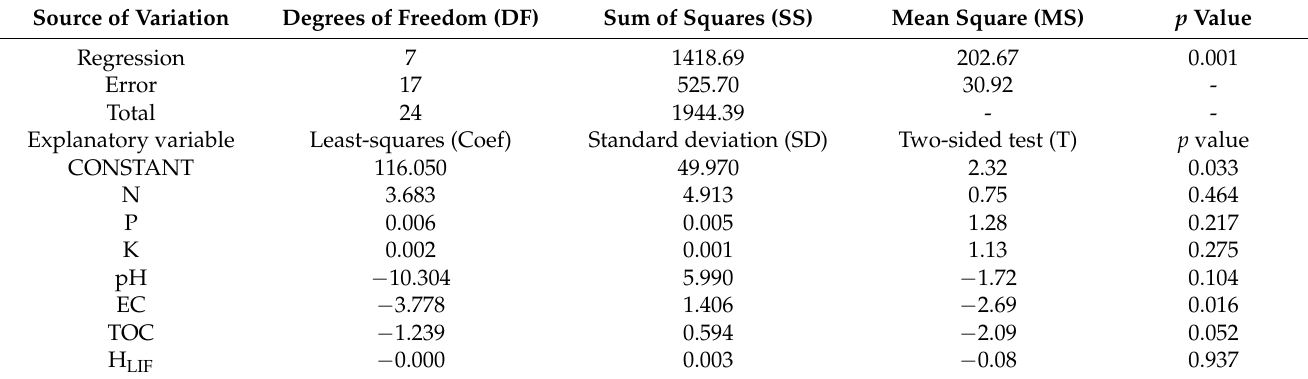
Table 3. Result of the Multiple Linear Regression analysis (MLR) using “parsley DM” as the response variable and “spectroscopic and physicochemical parameters of the organic amendments” as explana- tory variables. ANOVA calculations (Regression, Error and Total) that formed the basis for the test of significance for the model are also displayed in the table.